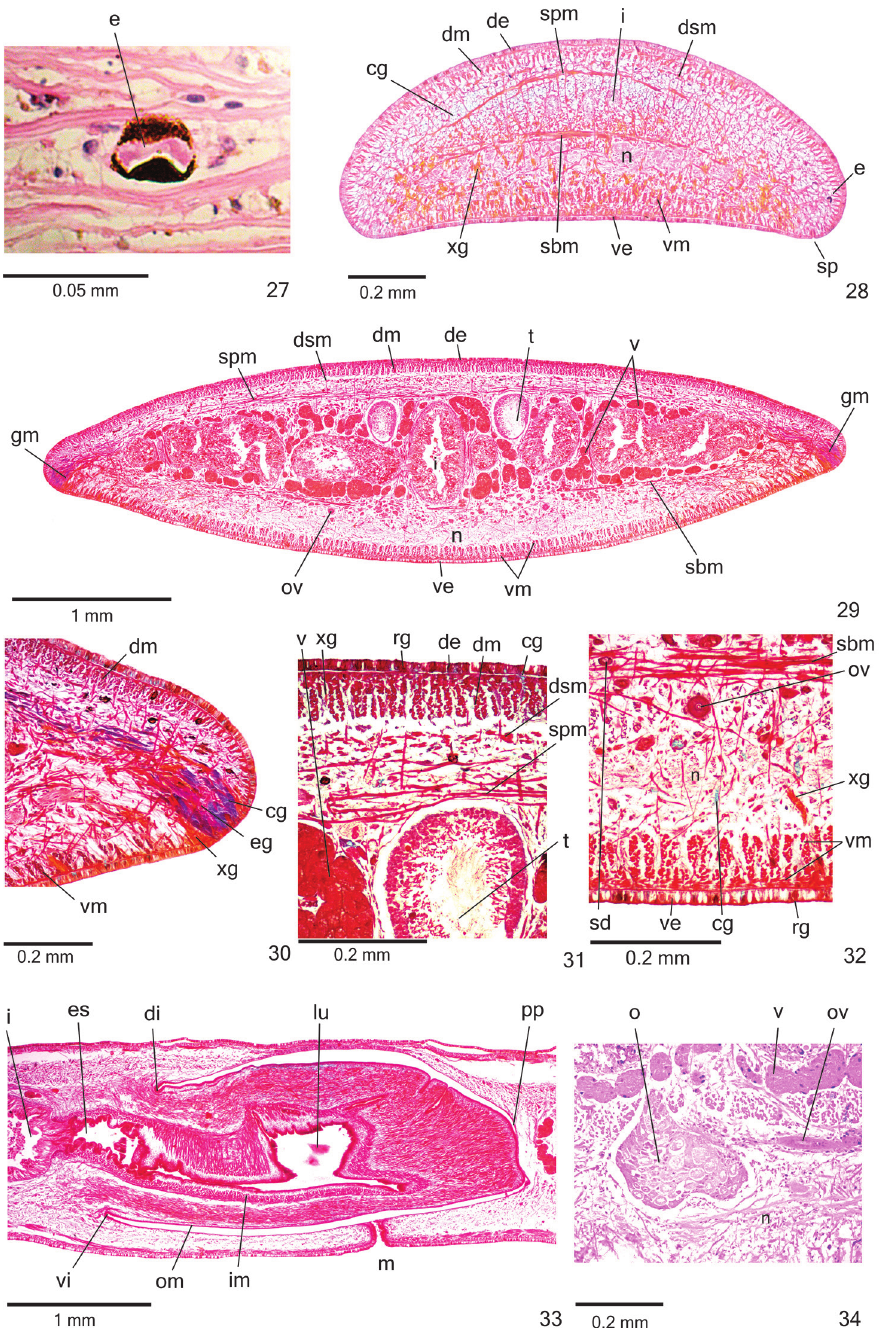
Figures 27–34. Cratera nigrimarginata sp. n., holotype, 27 dorsal eye, horizontal section 28 anterior region of body, transverse section 29–32 pre-pharyngeal region, transverse sections, body margin ( 30 ), dorsal portion ( 31 ), ventral portion ( 32 ) 33 pharynx, sagittal section 34 ovary, sagittal